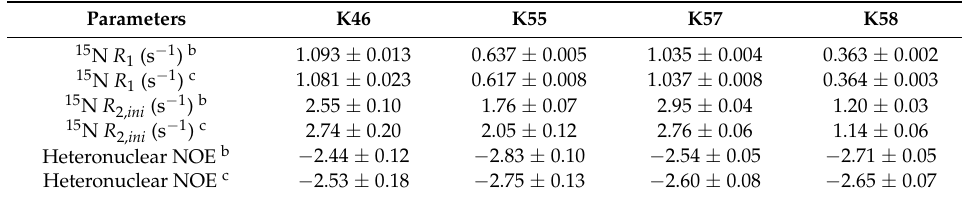
Figure 3. Comparison of the previous [15] and current pulse sequences for measuring 15 N relaxation of NH 3+ groups. ( a , b ) 15 N longitudinal (Panel a ) and transverse (Panel b ) relaxation of the K46 NH 3+ group. The vertical axis represents the signal intensity in the two-dimensional spectra measured as a function of the relaxation period T r . Solid lines represent the best-fit curves obtained through nonlinear least-squares fitting with a mono-exponential function; ( c ) Slices of the K46 NH 3+ signals along the 1 H dimension from the two-dimensional spectra with and without 1 H saturation for the sequences are shown in blue and red, respectively.